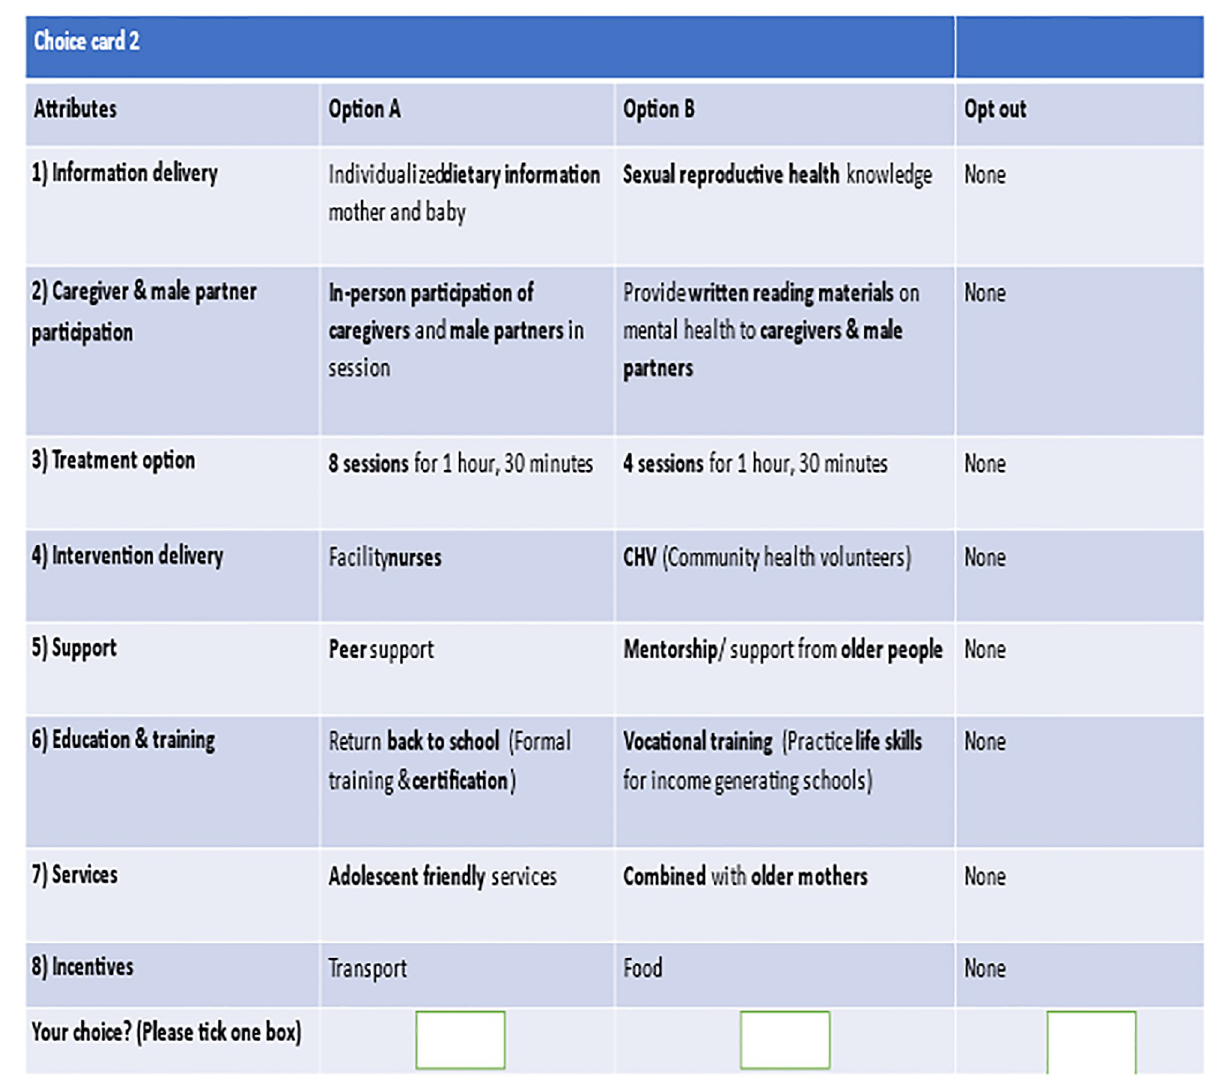
Fig 2. Sample choice card using orthogonal